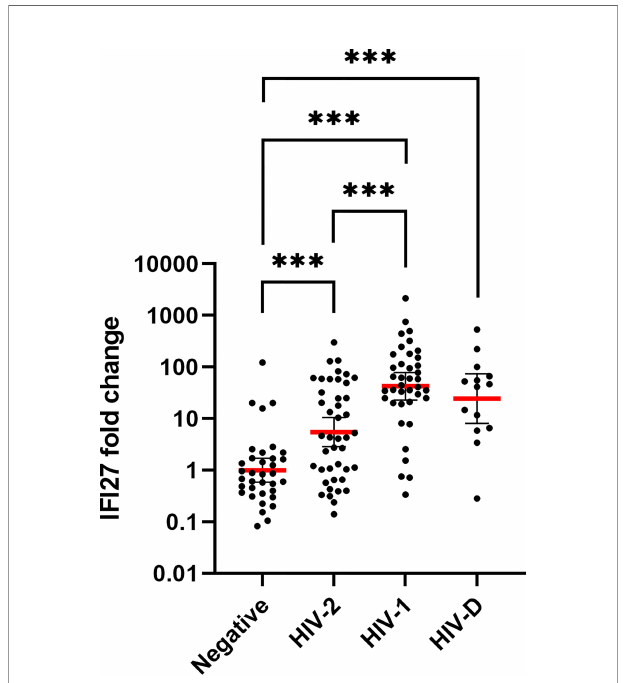
FIGURE 1 | IFI27 gene expression by HIV infection status. The relative IFI27 fold change gene expression, compared to HIV seronegative controls, was quanti fi ed and calculated by qPCR and the 2^- DD CT method, in whole blood of HIV seronegative (n = 35), HIV-2 (n = 43), HIV-1 (n = 39) and HIV-D (n = 14) infected individuals. The red line illustrates the geometric mean with con fi dence interval as error bars. IFI27 expression was log10-transformed prior to statistical comparison between groups using One-way ANOVA with Tukey ’ s post-hoc test. ***p <